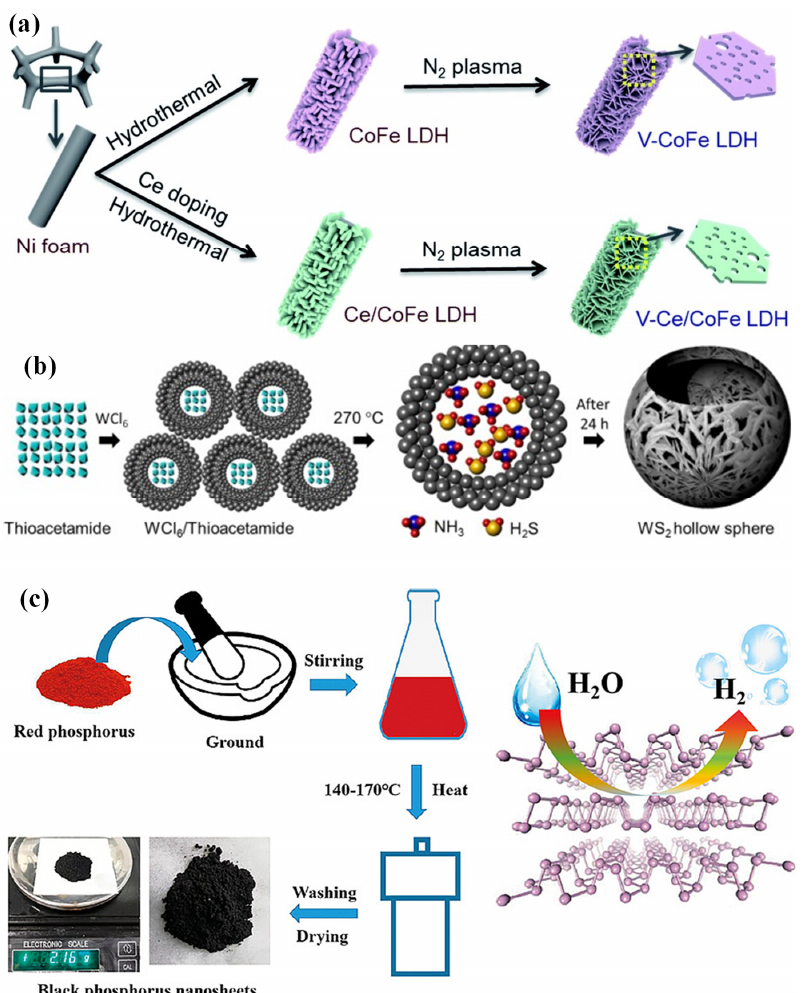
Figure 5. ( a ) Schematic illustration of synthesis of V-CoFe LDH and V-Ce/CoFe LDH through hydrothermal method fol- lowed by N 2 plasma itching [54]. ( b ) Synthesis of WS 2 hollow structure using a facile hydrothermal method [55]. ( c ) Sche- matic procedure of solvothermal synthesis of BP nanosheets for efficient HER and the inset image shows that the yield can be up to 2.1 g [59].